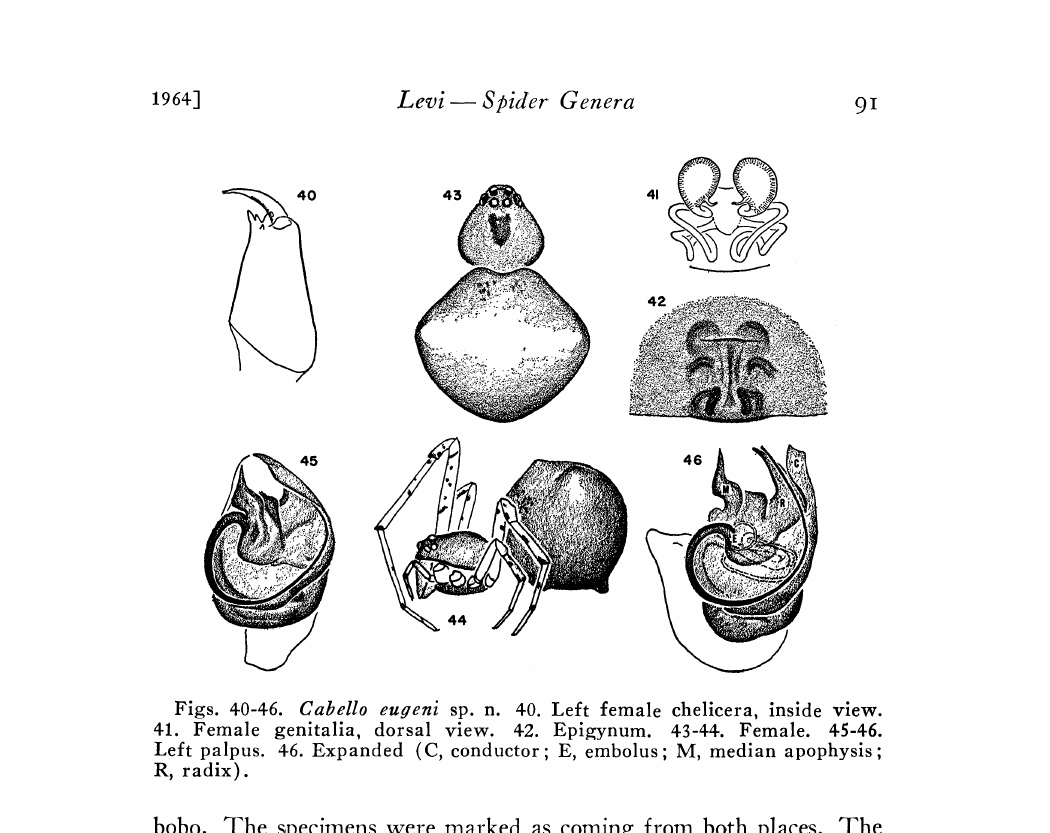
Figs. 40-46. Cabello eugeni sp. n. 40. Left female chelicera, inside view. 41. Female genitalia, dorsal view. 42. Epigynum. 43-44. Female. 45-46. Left palpus. 46. Expanded (C, conductor; E, embolus; M, median apophysis; R, radix). bobo. The specimens were marked as coming from bo.th places. The species is named after its